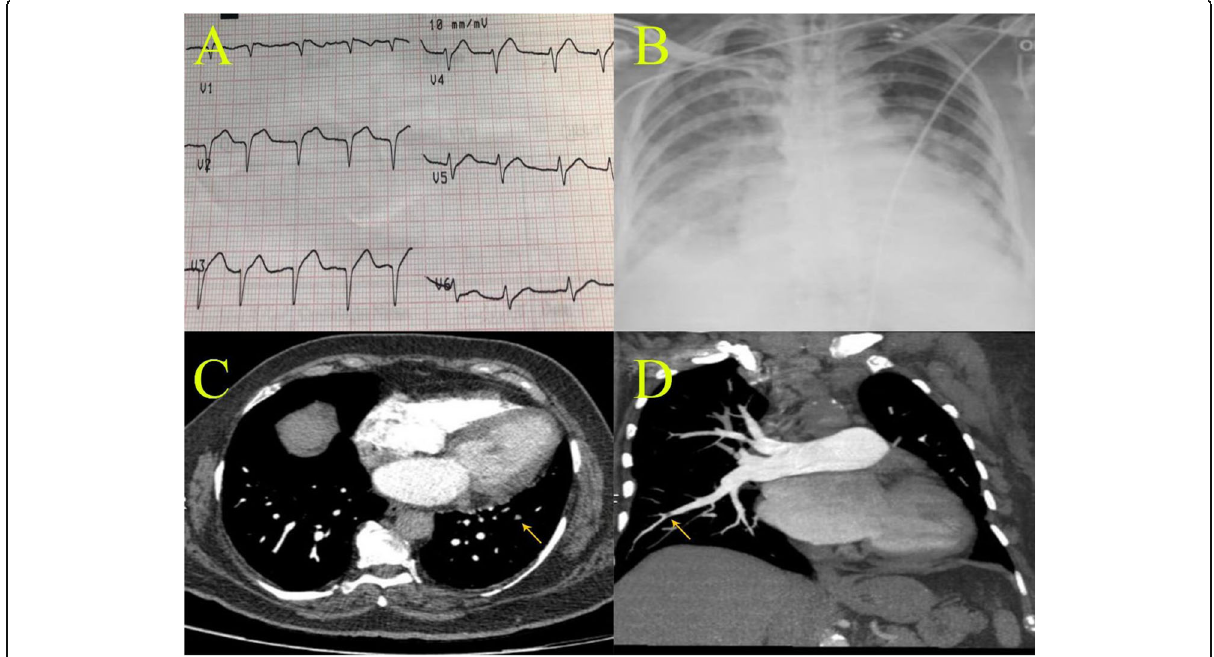
Fig. 1 (Panel a ) ECG showing atrial fibrillation rhythm and Q waves with residual ST elevation in the anterior chest leads, (panel b ) chest X-ray showing increased cardiac shadow with bilateral lung infiltrations with classic ground glass opacities, (panels c and d ) MSCT pulmonary angiography showing a picture of acute pulmonary thromboembolism (PTE) involving subsegmental branches of both lower lung lobes (yellow